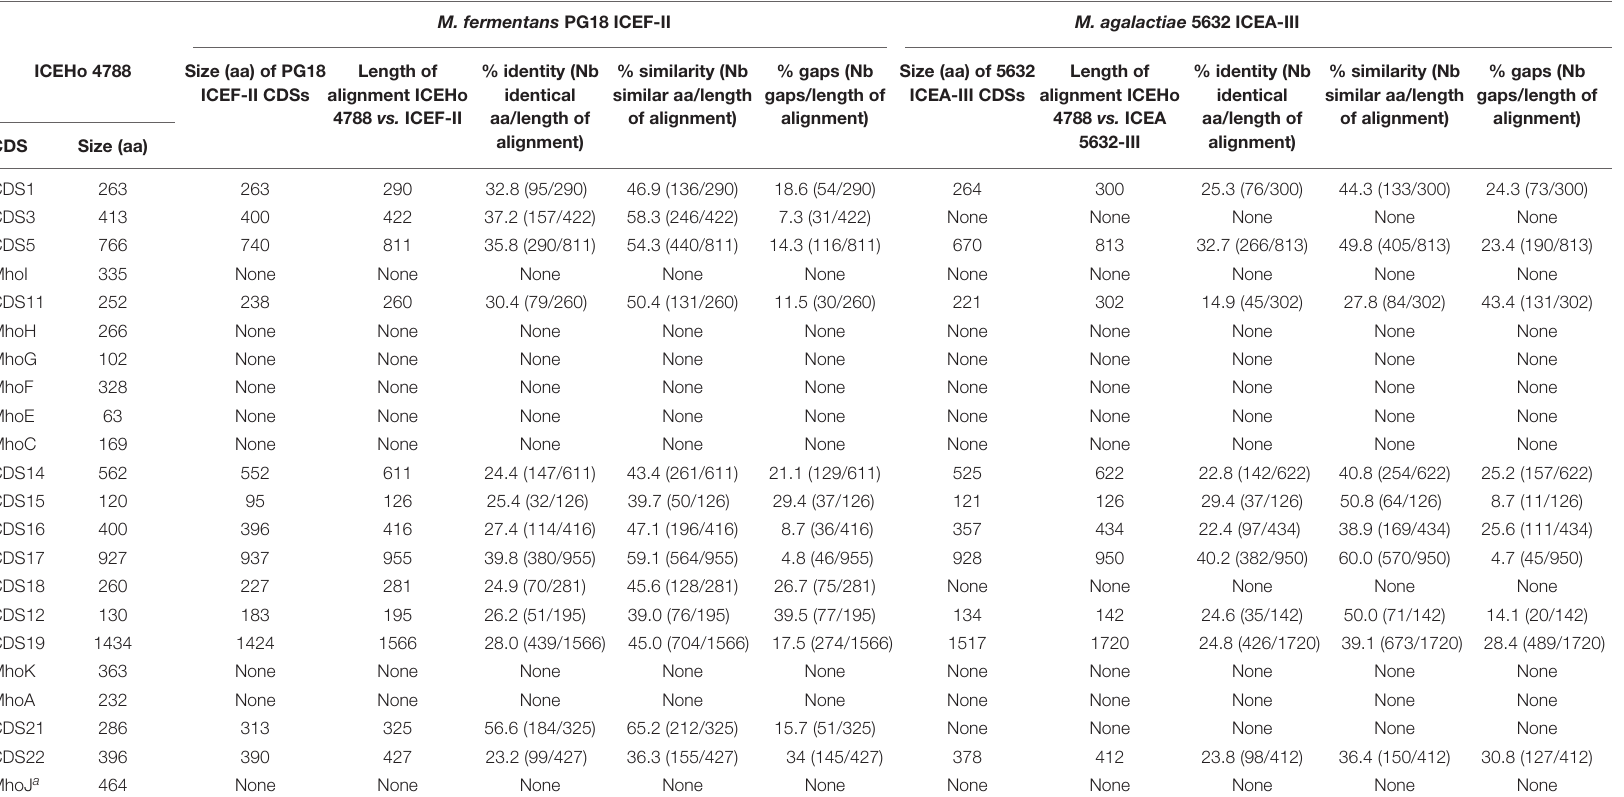
TABLE 3 | Comparison of CDSs from M. hominis ICEHo 4788 with CDSs from M. fermentans PG18 ICEF-II and M. agalactiae 5632 ICEA-III.